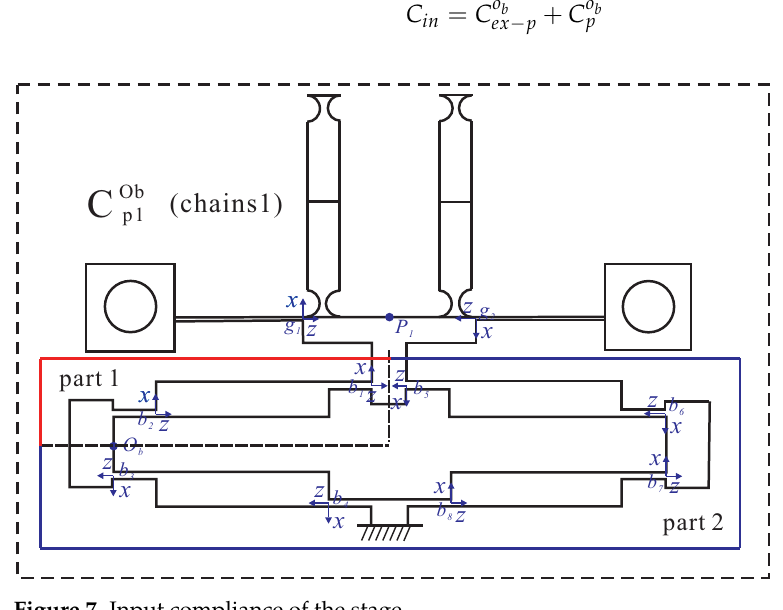
Figure 7. Input compliance of the